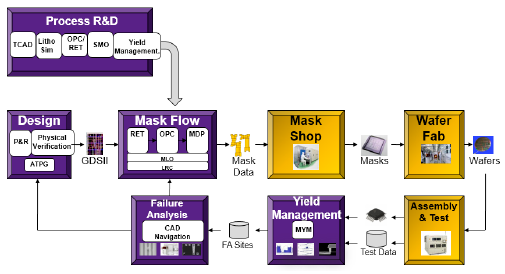
Figure 2. Fabrication centric solutions for process/product ramp production.